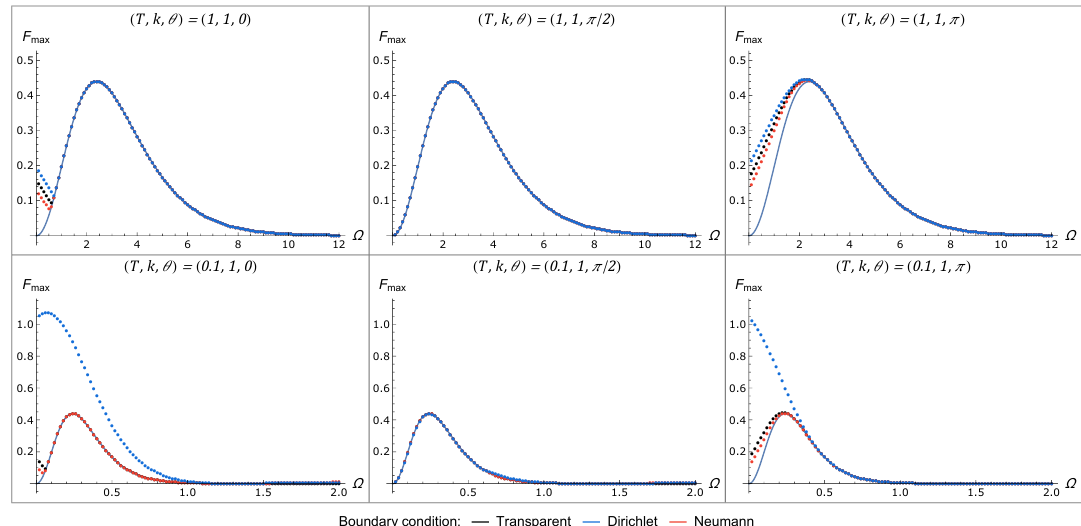
Figure 7 . (Approximate) temporal maximum of the Fisher information in AdS 4 . Every panel corresponds to a different choice of ( T, k, θ ) . Again, the three colors correspond to different boundary conditions. The asymptotic Fisher information is shown as a solid